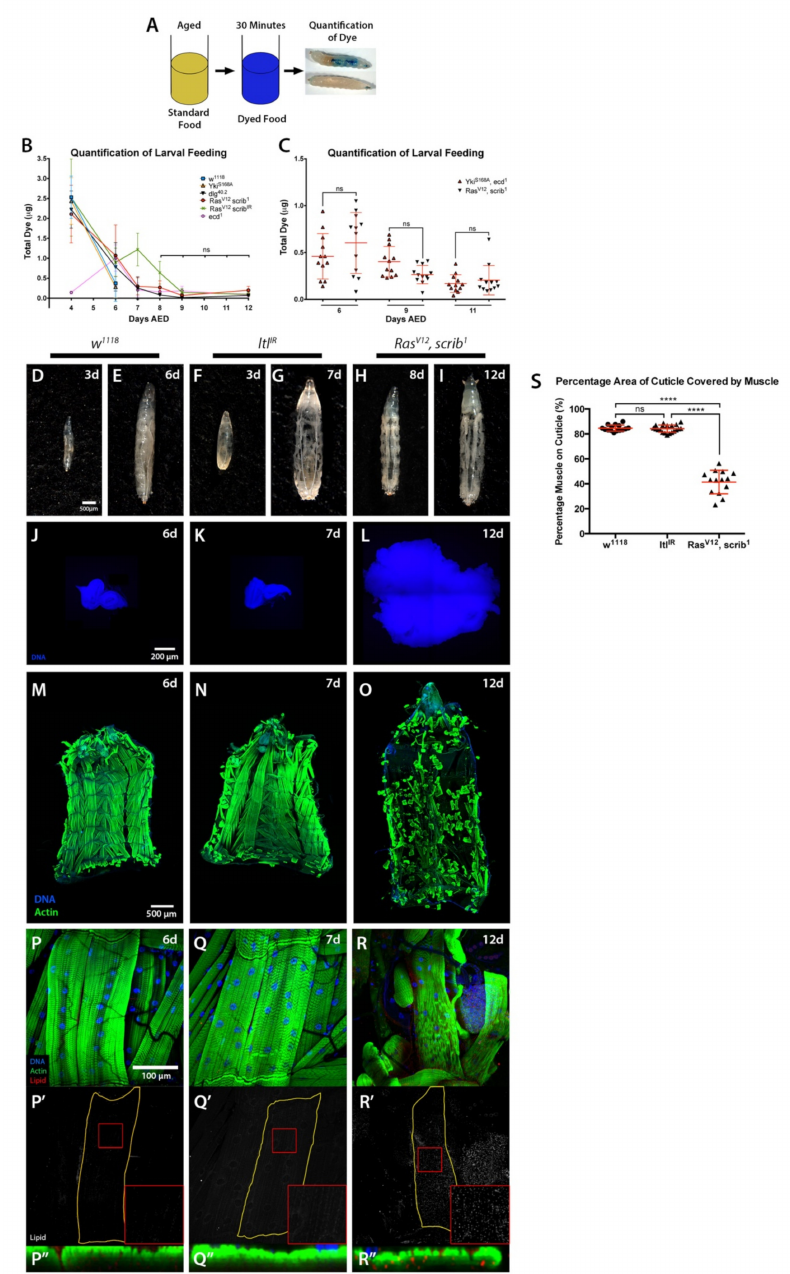
Figure 3. Starvation or bloating are not sufficient to drive cachexia. ( A ) Schematic of the approach for assessment of larval feeding. ( B , C ) Quantification of dye levels consumed by larvae of the indicated genotypes. ( D – I ) Images of whole larvae. Normal ( w 1118 ) larvae at 3 ( D ) and 6 ( E ) days AED. Tumour-free bloated larvae with ubiquitous tubulin > Gal4 -driven expression of ltl IR at 3 ( F ) and 7 ( G ) days AED. Ras V12 , scrib 1 tumour-bearing larvae at 8 ( H ) and 12 ( I ) days AED. ( J – L ) Imaginal tissues stained with DAPI. Normal eye-antennal disc at 6 days AED ( w 1118 ) ( J ), eye-antennal disc at 7 days AED ( tub > ltl IR ) ( K ), and invasive neoplastic eye tumours at 12 days AED ( Ras V12 , scrib 1 ) ( L ). ( M – O ) Cuticles with muscle actin stained with Phalloidin, animals of ages and genotypes as described for ( J – L ). ( P – R” ) 5th segment of the 7th ventral muscle, stained with DAPI (blue), Phalloidin (green), and LipidTOX (grey or red). Animal ages and genotypes as described for ( J – L ). All panels denoted ( (cid:48) ) show lipid staining only. All panels denoted ( (cid:48)(cid:48) ) show a transversal orthographic view of muscle with a 2X zoom. ( S ) Quantification of the percentage of the cuticle covered by muscle. All graphs show one-way ANOVA with Tukey post hoc correction. Mean ± SEM is indicated. ns: non-significant, p > 0.05; **** p ≤